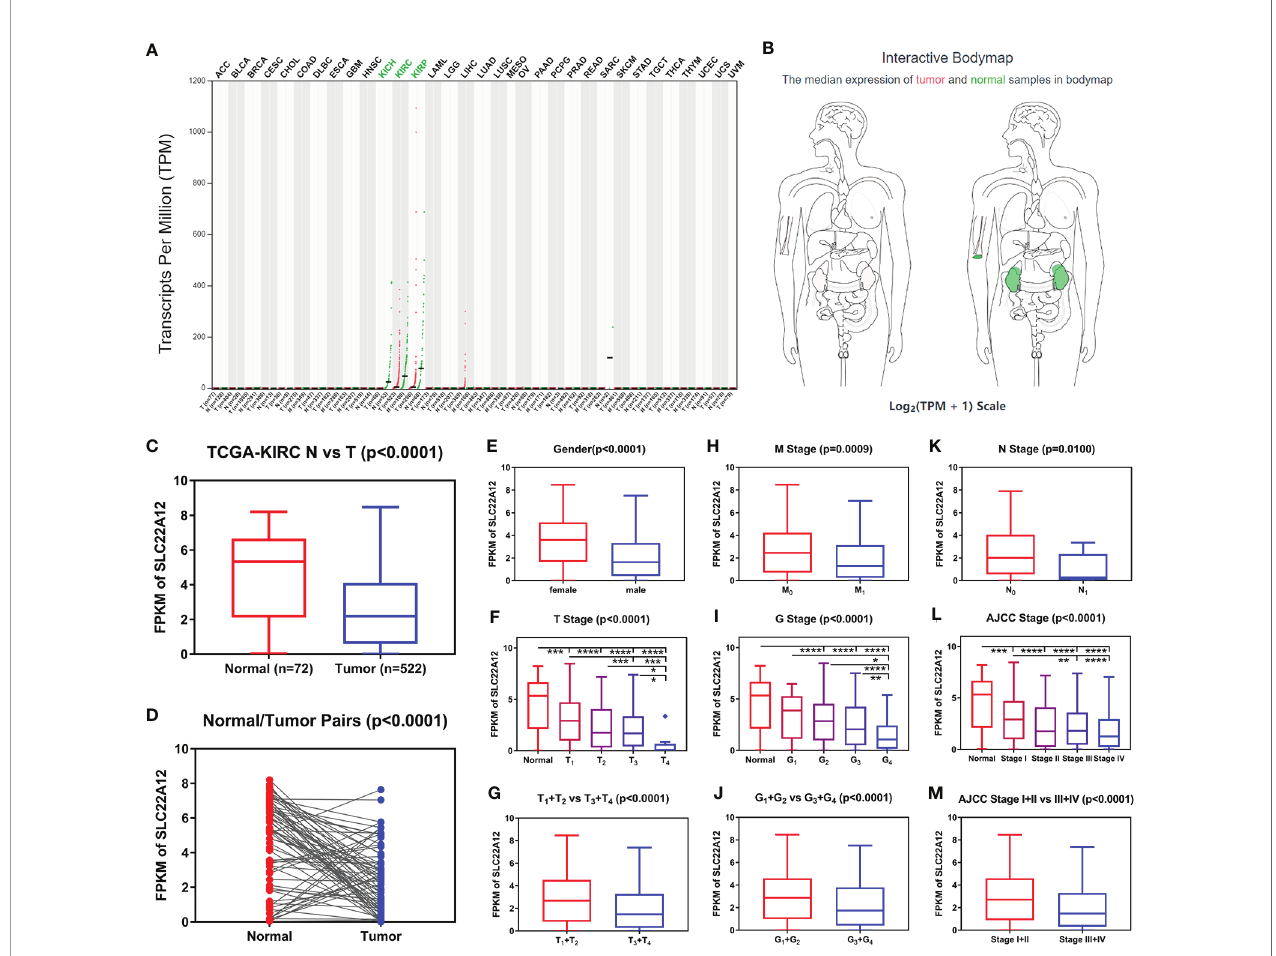
FIGURE 2 | Transcriptome pro fi le of SLC22A12 of kidney cancer in TCGA database. (A) Transcriptome pro fi le of SLC22A12 in multiple types of cancers and their corresponding normal tissues in TCGA database. (B) Distribution of SLC22A12 RNA expression levels across organs. The mRNA expression levels of SLC22A12 were lower in (C) 522 ccRCC tissues than in 72 para-cancer tissues, (D) 72 ccRCC tissues than in 72 corresponding adjacent normal tissues. SLC22A12 expression was lower in (E) male, (F, G) higher T stage, (H) higher M stage, (I, J) higher G stage, (K) higher N stage, and (L, M) higher AJCC clinical stage. *p < 0.05, **p < 0.01, ***p < 0.001, ****p <